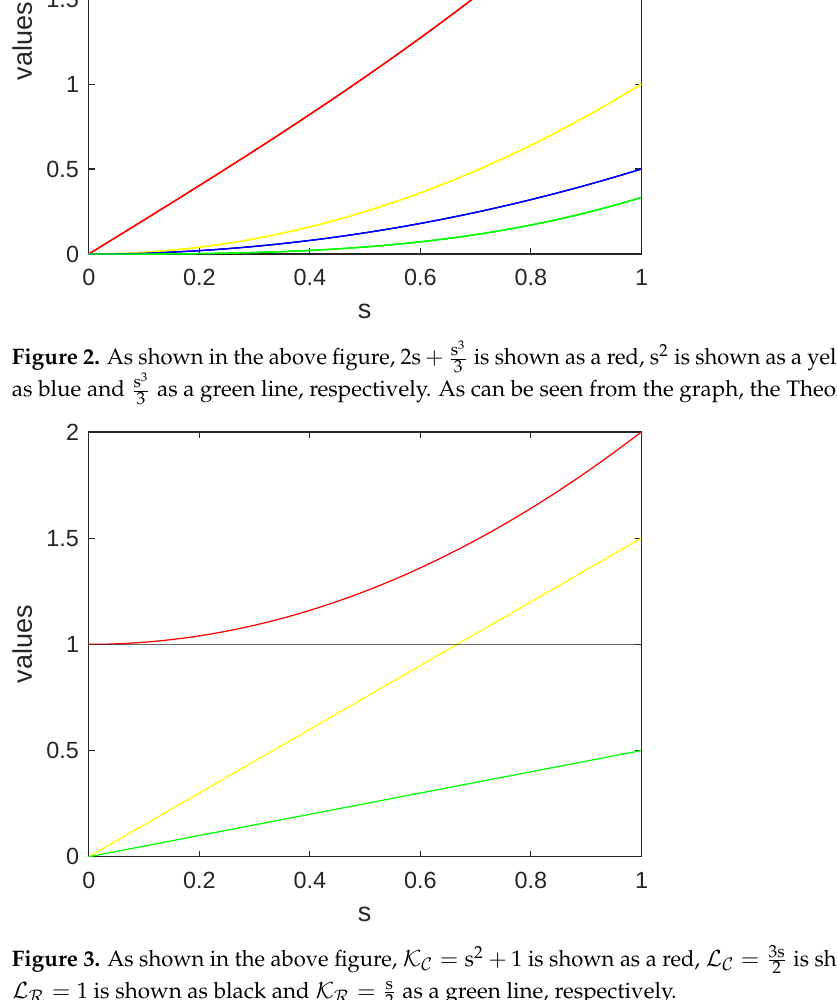
as a green line, 2